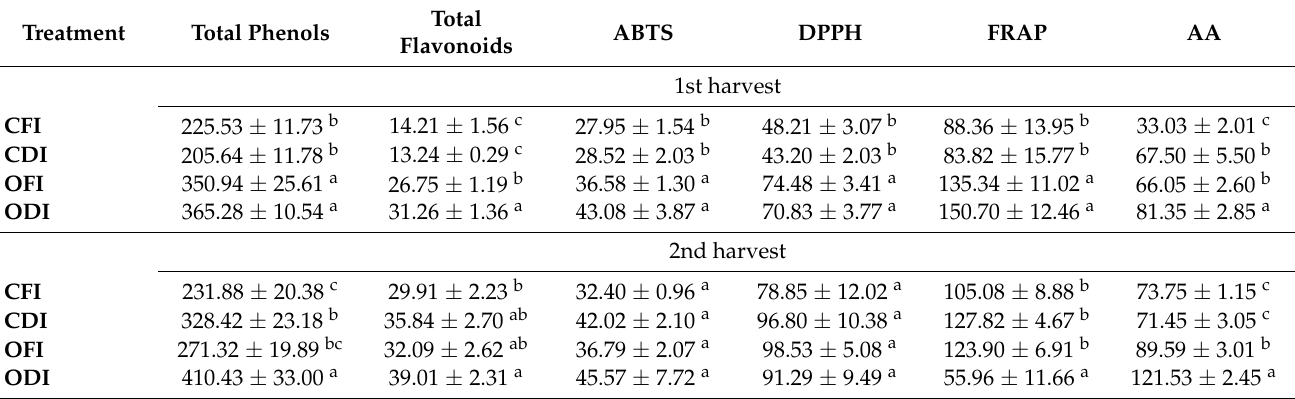
Table 3. Effect of cultivation (conventional-C or organic-O) and irrigation (full irrigation-FI or deficit irrigation-DI) practices on Mellissa plants, total phenolics ( µ mol GAE/g Fw), total flavonoids (mg rutin/g Fw), antioxidant status (ABTS, DPPH, FRAP; mg Trolox equivalents/g Fw) and ascorbic acid (AA; mg/g Fw) under two